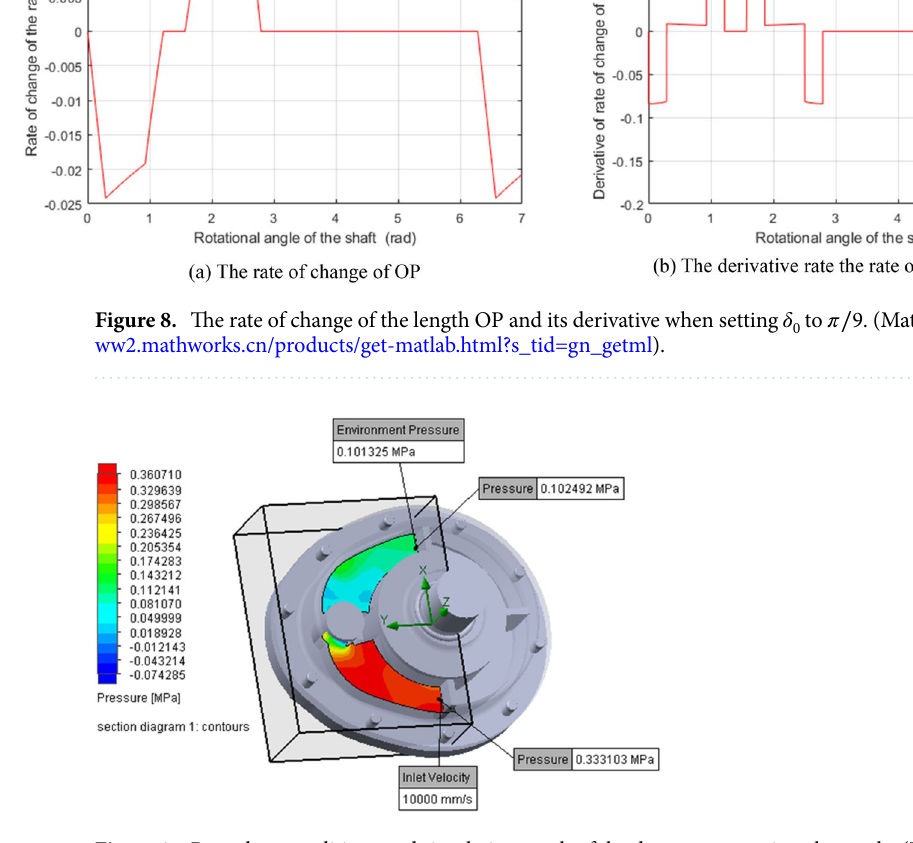
Figure 9. Boundary conditions and simulation result of the damper at certain valve angle. (FloEFD, trial version. https:// www. plm. autom ation. sieme ns. com/ global/ en/ produ cts/ simce nter/ floefd.